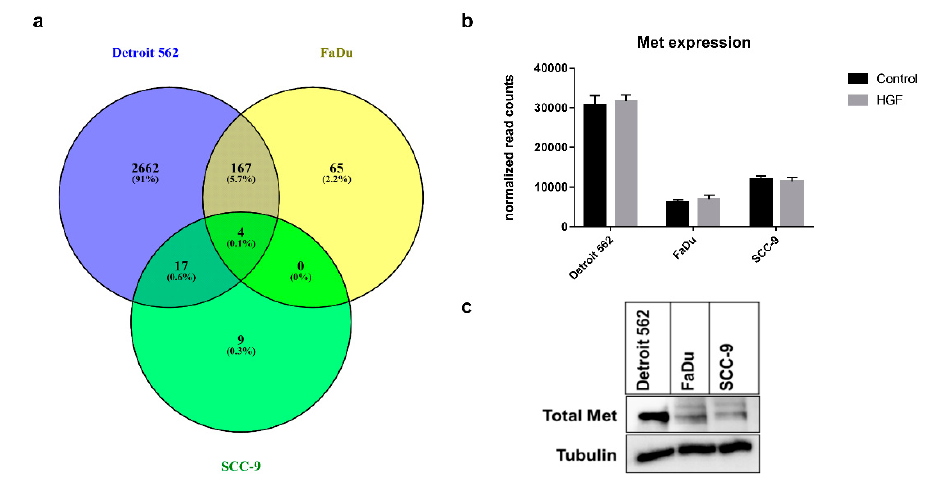
Figure 4. ( a ) Venn diagram showing the di ff erences and overlap in induced or downregulated genes between the three cell lines upon 16 h of HGF stimulation (50 ng / mL). Genes with a di ff erence in expression of ≥ 0.4 or ≤ -0.4 (log 2 fold change) and p adj < 0.1 (see Materials and Methods) were considered induced / downregulated. ( b ) Diagram showing mRNA sequencing-based normalized gene expression levels for the gene MET. HGF-stimulated samples in grey, unstimulated control in black. ( c ) Immunoblotting showing the protein expression of MET in the investigated cell lines (Total Met). As a loading control, the blot was reprobed using an antibody recognizing tubulin. A typical experiment out of three is